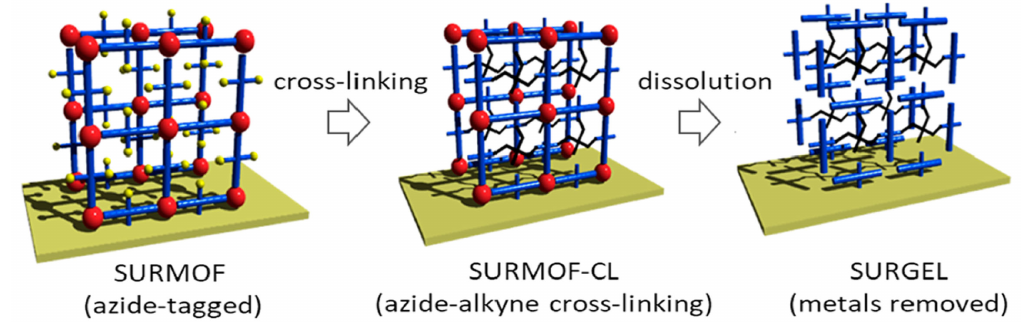
Figure 10. Transformation of azide ‐ tagged SURMOF into surface ‐ anchored polymeric gel (SURGEL) via azide-alkyne cross-linking and subsequent metal removal after dissolution via azide ‐ alkyne cross ‐ linking and subsequent metal removal after dissolution [96].